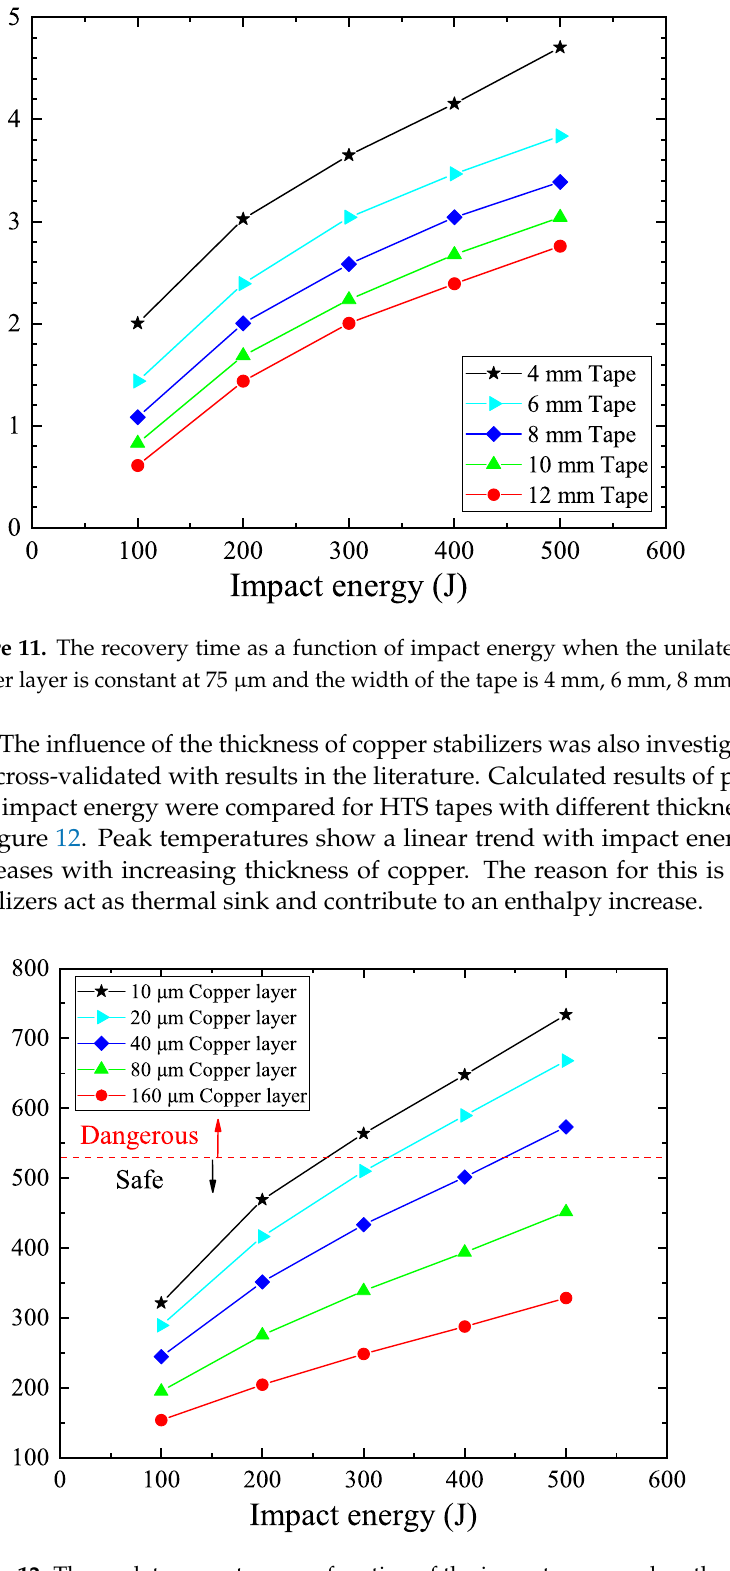
Figure 12. The peak temperature as a function of the impact energy when the width of the tape is constant at 4.8 mm and the unilateral thickness of the copper layer in the tape is 10 µ m, 20 µ m, 40 µ m, 80 µ m and 160 µ